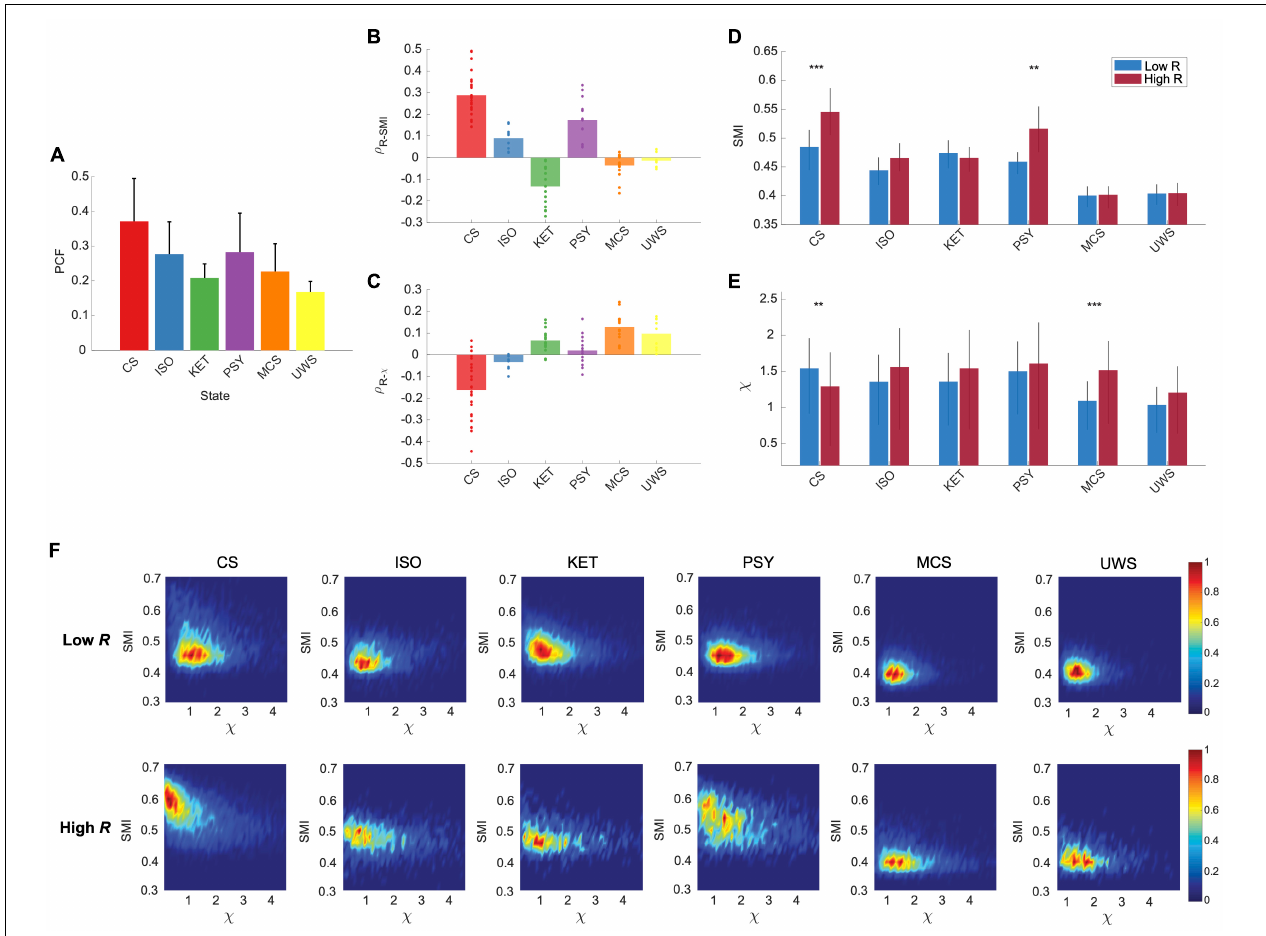
FIGURE 5 | The preferences of the brain network for internal information integration in the network and external responsiveness are significantly disrupted in different states of consciousness (CS: conscious state, ISO: isoflurane-induced unconsciousness, KET: ketamine-induced unconsciousness, PSY: subanesthetic ketamine-induced psychedelic state, MCS: minimally conscious state, and UWS: unresponsive wakefulness syndrome). (A) PCF in different states of consciousness (Mean ± SD). The CS shows the largest PCF as expected in the brain network model. PCFs are significantly different among the states except for the ISO and PSY pair and the KET and MCS pair ( p < 0.001, Kruskal-Wallis test with a multiple-comparison test using Tukey-Kramer method). Spearman correlations between (B) R and SMI and (C) R and χ in different states of consciousness. Dots indicate the correlation values of subjects. As expected in the model study, CS shows a maximum positive (negative) correlation between R and SMI (R and χ ), and these relationships are disrupted in the different states of consciousness. (D) SMI and (E) χ for low and high R windows in different states of consciousness. Only CS shows significant differences between high and low R windows in both SMI and χ (*** p < 0.001 and ** p < 0.005; Wilcoxon rank-sum test). (F) Joint histograms of different states of consciousness. The distinct preferences of low and high R windows disrupt in all different states of consciousness (ISO, KET, PSY, MCS, and